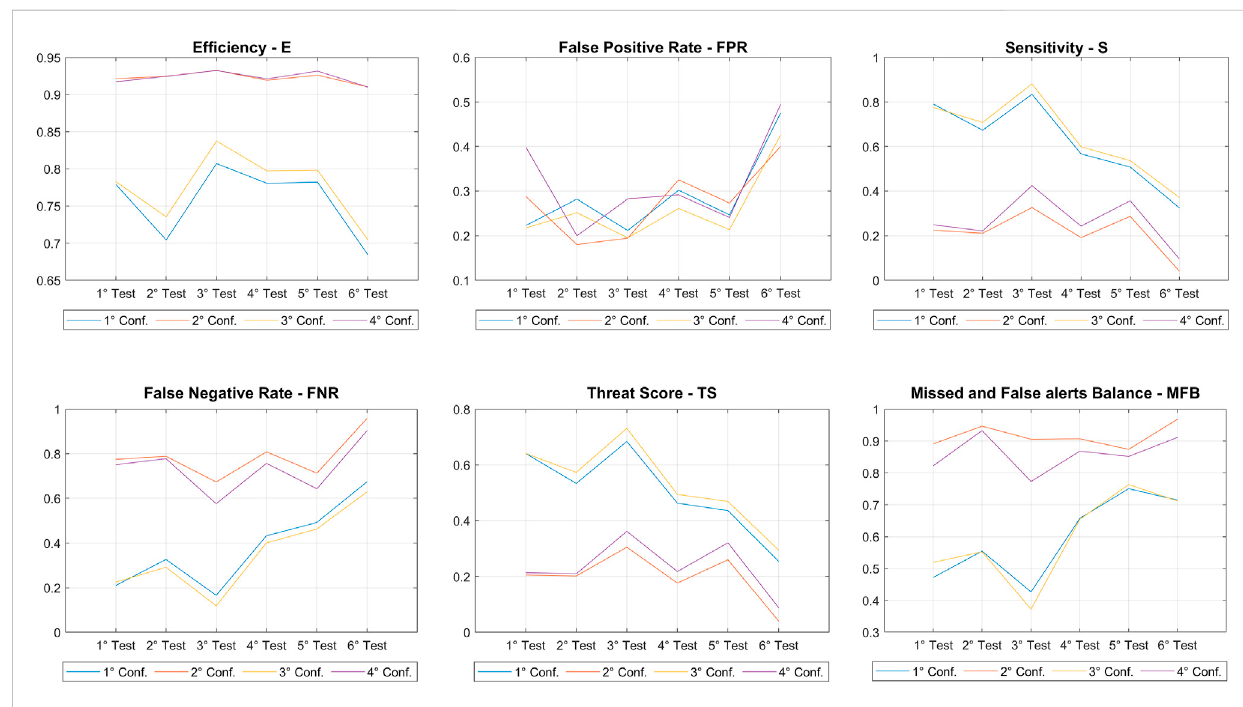
FIGURE 14 Trend of the various performance indicators analysed based on each test and combination.